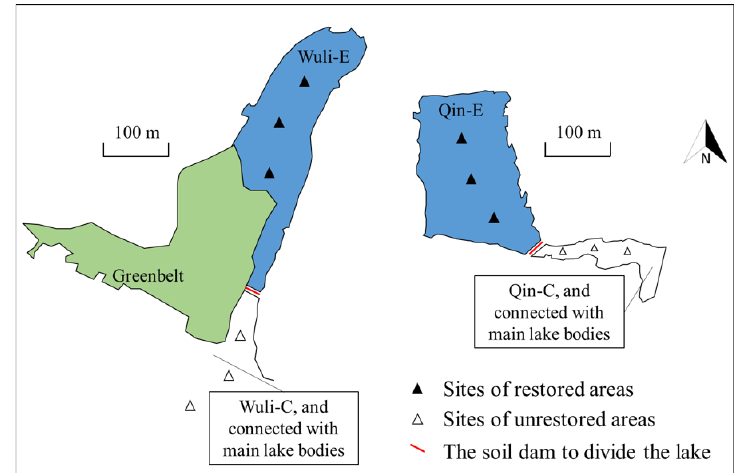
Figure 1. Location of the studied lakes restored (Wuli-E and Qin-E) and the unrestored lake area (Wuli-C and Qin-C) in Lake Wuli and Lake Qinhu with sample sites in this study. Table 1. Summary of study area information, including the overlying water parameters acquired before restoration and sediment parameters from the restored area. Standard deviations are given. SD refers to Secchi depth, TP refers to concentrations of total phosphorus, TN refers to total nitrogen and TOC refers to total organic carbon. These indicators were monitored one month before the restoration starting.